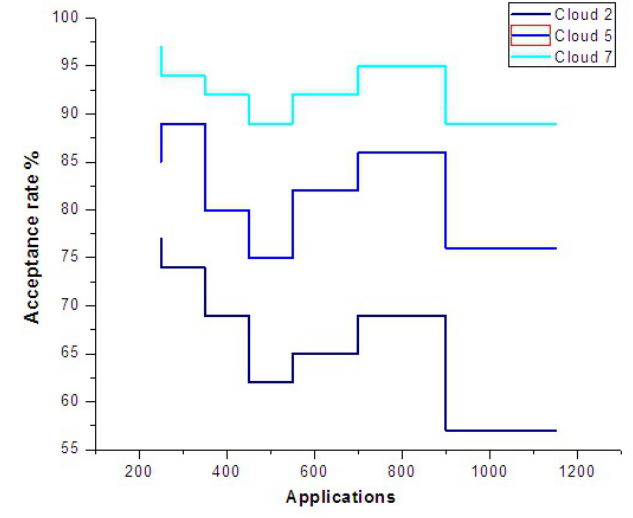
Figure 19. Application acceptance